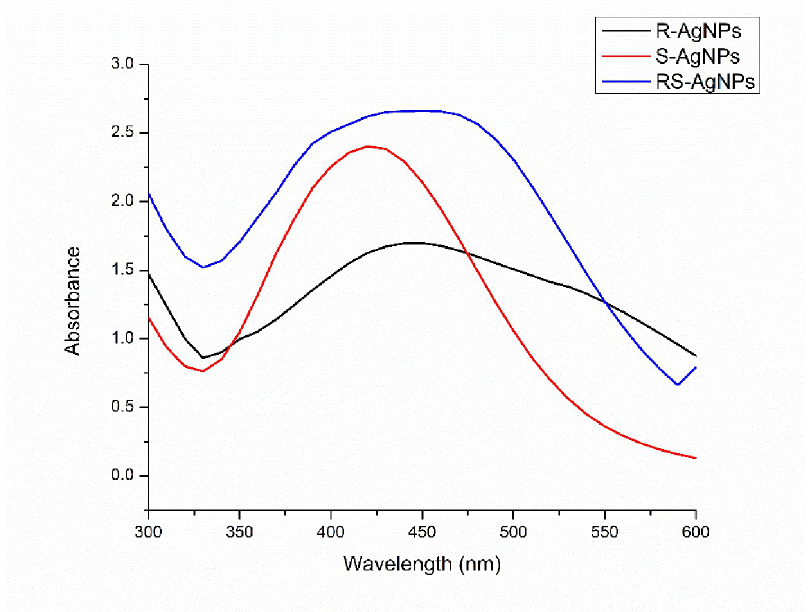
Fig 2. UV-Vis spectrophotometric analysis of AgNPs synthesized using various parts of D . uncinatum